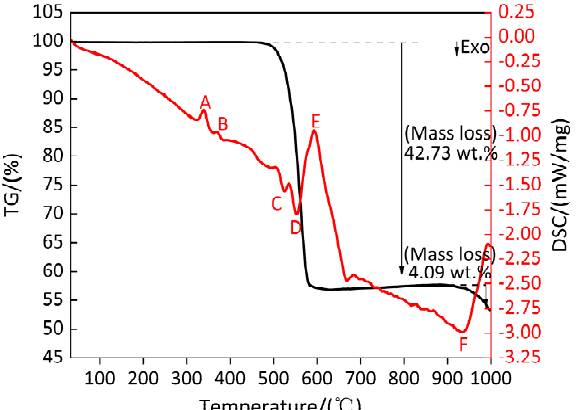
Figure 20. TG/DSC curve of Al-rich Al/PTFE/TiH 2 composite. A, B and E: Endothermic peak; C, D and F: Exothermic peak.